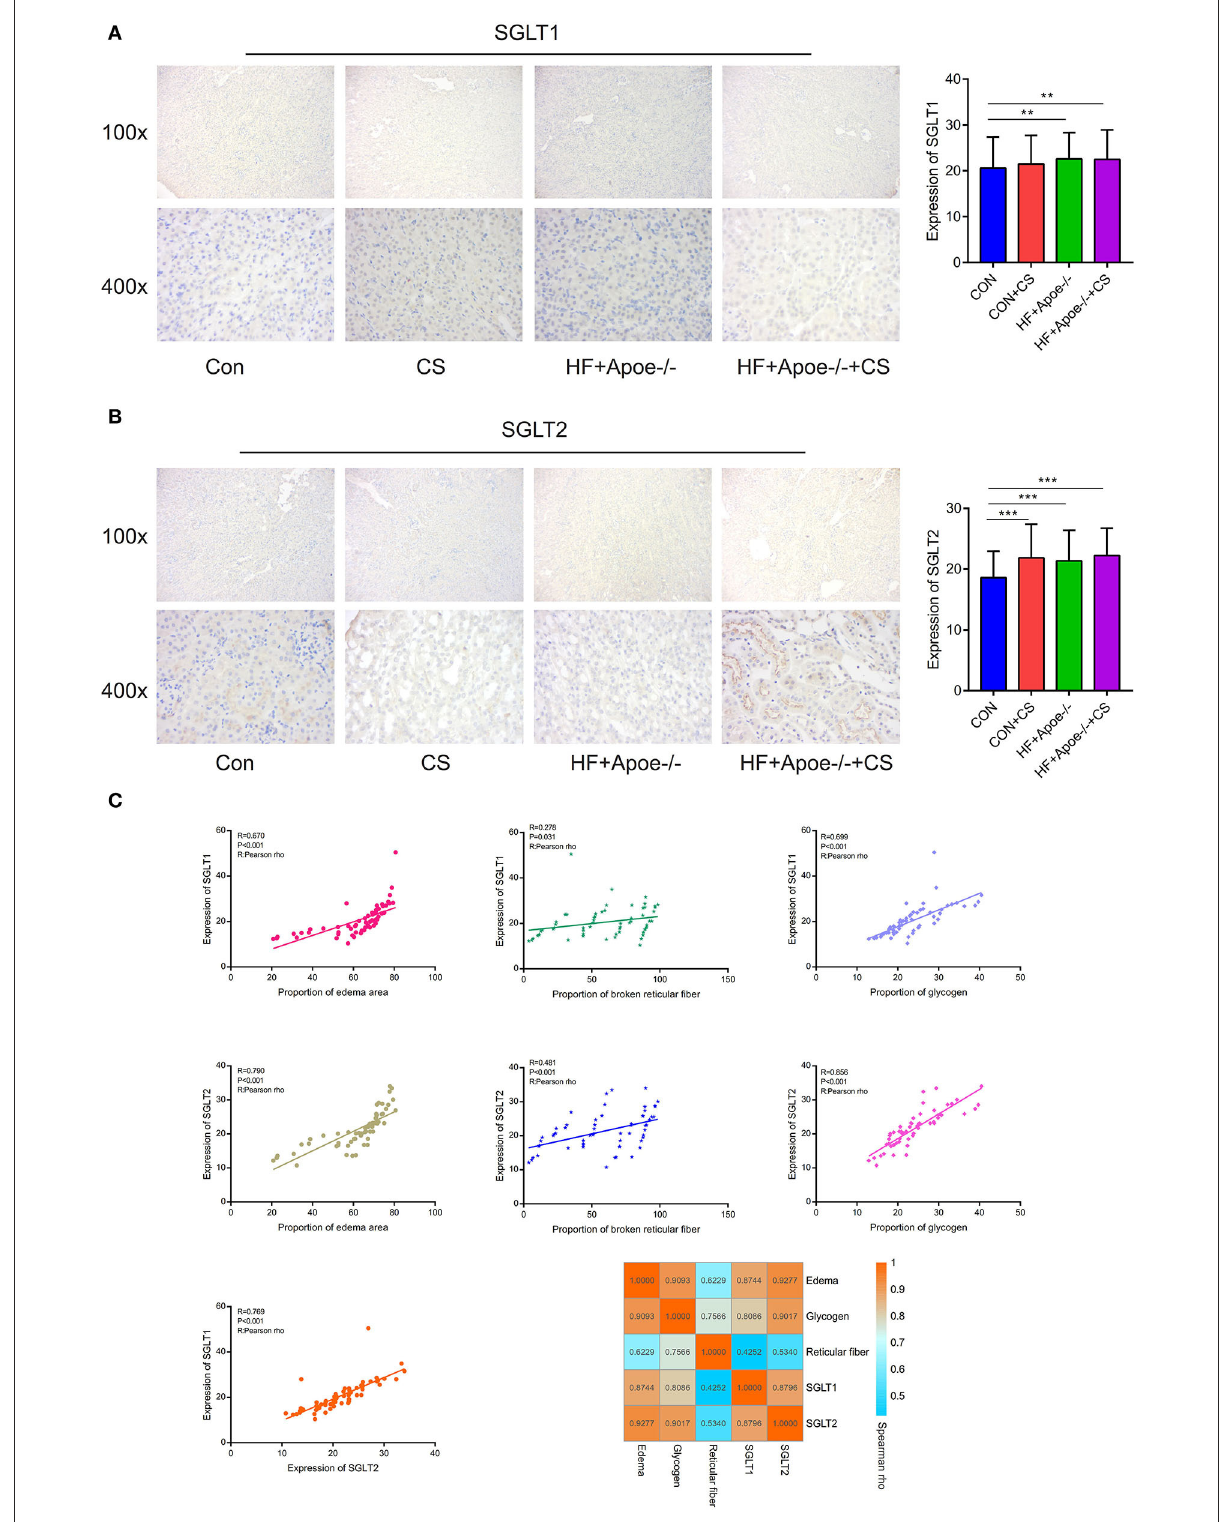
FIGURE6 Verification of the expression of SGLT1 and SGLT2 in the kidney via the immunohistochemical assay. (A) Through the immunohistochemical assay, the expression of SGLT1 in the kidney in the HF + Apoe − / − group and HF + Apoe − / − + CS group was upregulated compared with the CON group. (B) Compared with the CON group, the expression level of SGLT2 in the kidney was higher in the CON + CS, HF + Apoe − / − , and HF + Apoe − / − + CS groups. (C) Positive correlations edema, glycogen, reticular fiber, and expression of SGLT1 and SGLT2 in the kidney. ** P < 0.01; *** P <